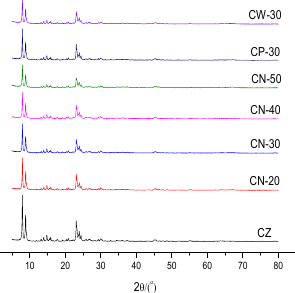
Figure 1. XRD patterns of the catalysts.